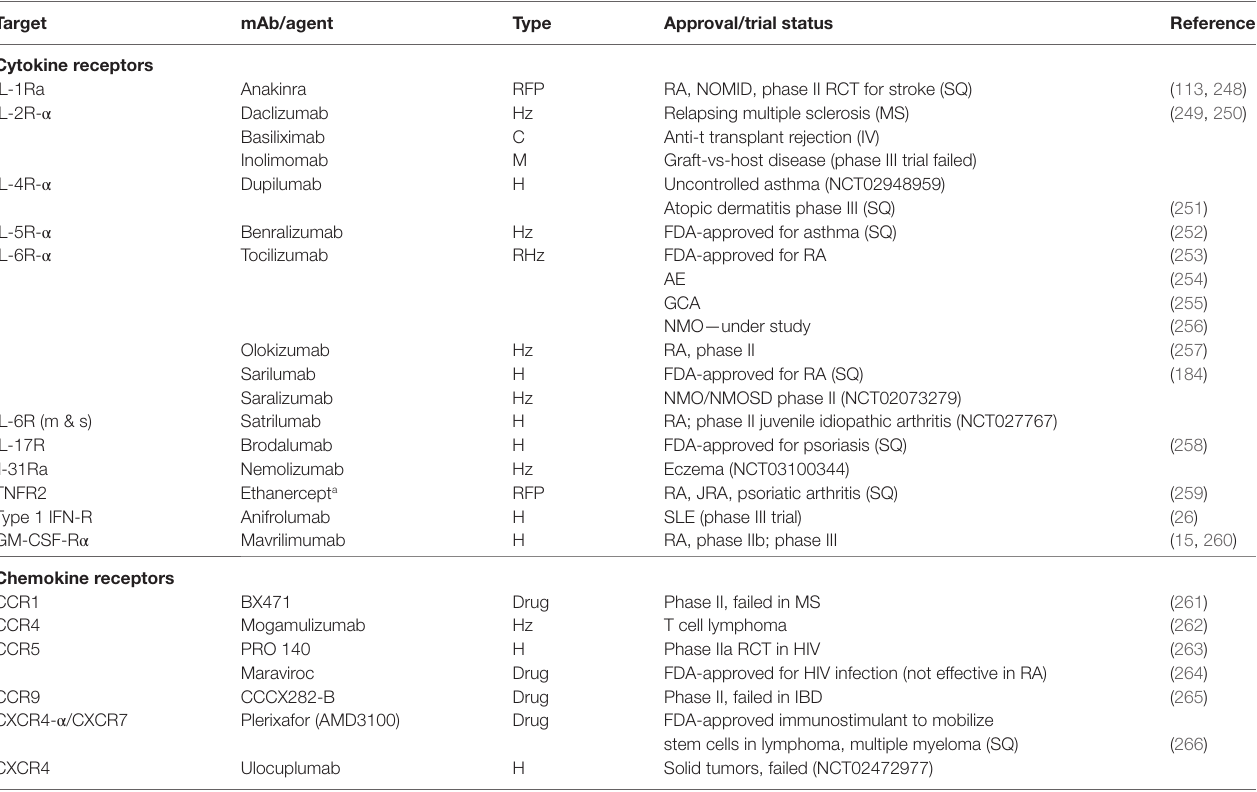
TABle 9 | Overview of some clinical trials/approvals for targeting chemo/cytokine